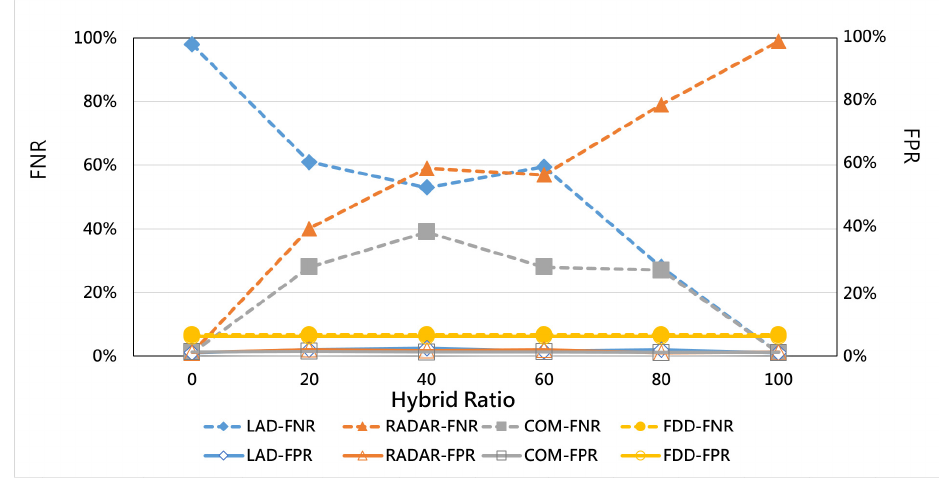
Figure 6. FNR and FPR vs. hybrid